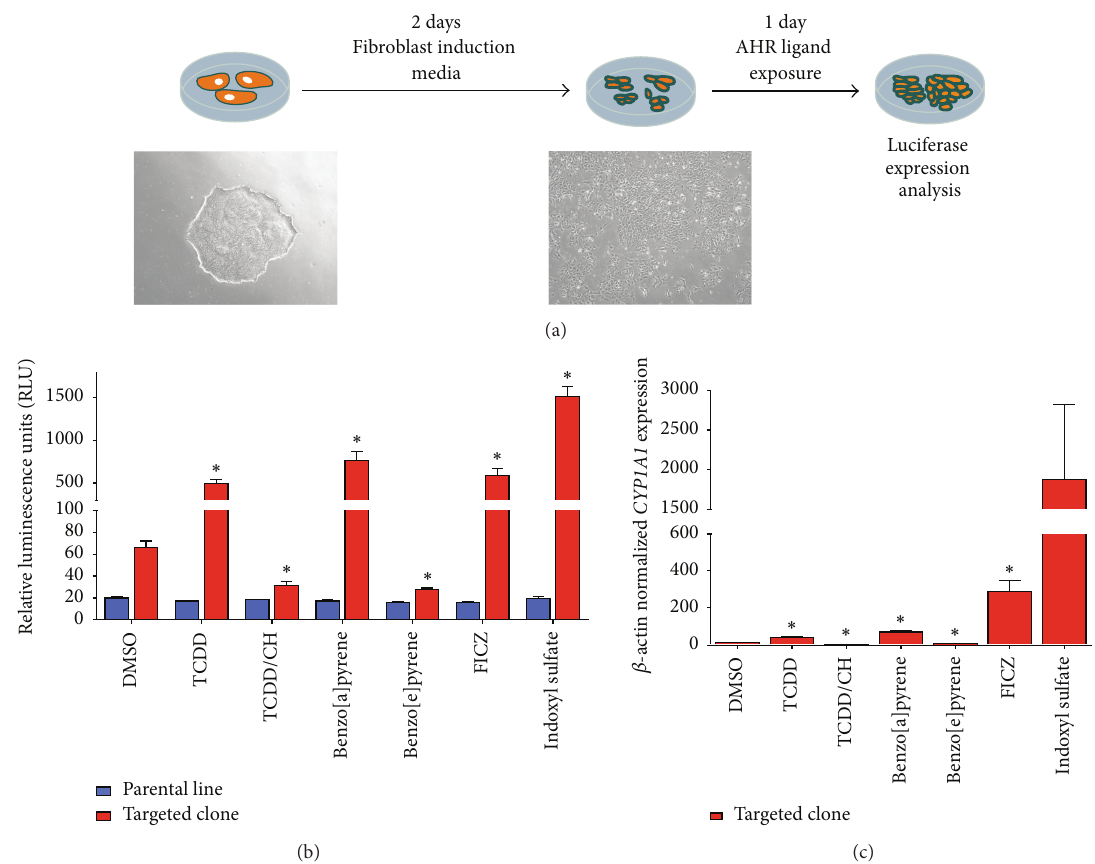
Figure 3: Acute exposure to AHR ligands causes a predictable response in CYP1A1 reporter iPSCs. (a) Fibroblast-like cells were differentiated from CYP1A1 iPSCsoverthecourseof2daysusingfibroblastinductionmedia.AcompendiumofAHRligandswerethenaddedtothecultures for 24 hours before cells were harvested for further analysis. (b) Luciferase expression analysis reveals patterns of activation and inhibition of the CYP1A1 reporter (targeted clone) as a response to agonist and antagonist treatment. Significance was established by Student’s 𝑡 -test for each condition compared to the DMSO control condition ( ∗ 𝑃 < 0.01 , 𝑁 = 3 ) (c) Transcript level expression of endogenous CYP1A1 in the targeted clone showed similar patterns of modulated expression that positively correlated to luciferase output. Significance was established by Student’s 𝑡 -test for each condition compared to the DMSO control condition ( ∗ 𝑃 < 0.02 , 𝑁 = 3